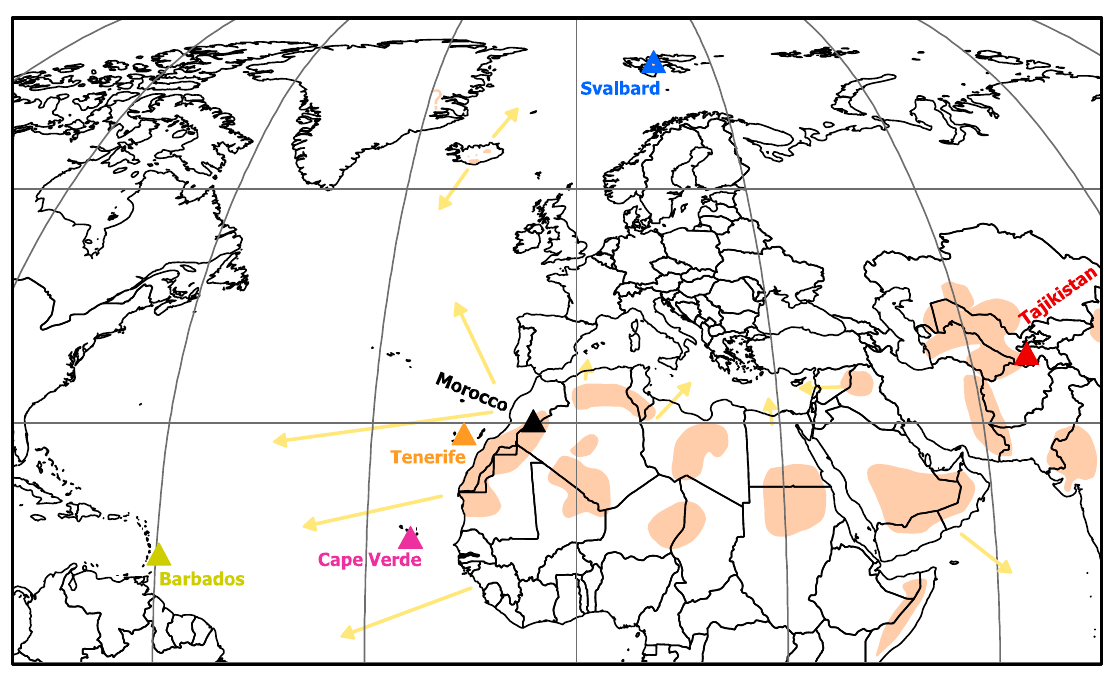
Figure 1. Map of the measurement locations, dust sources, and major transport pathways. Sources and pathways were drawn according to literature information [30,31,45–50].